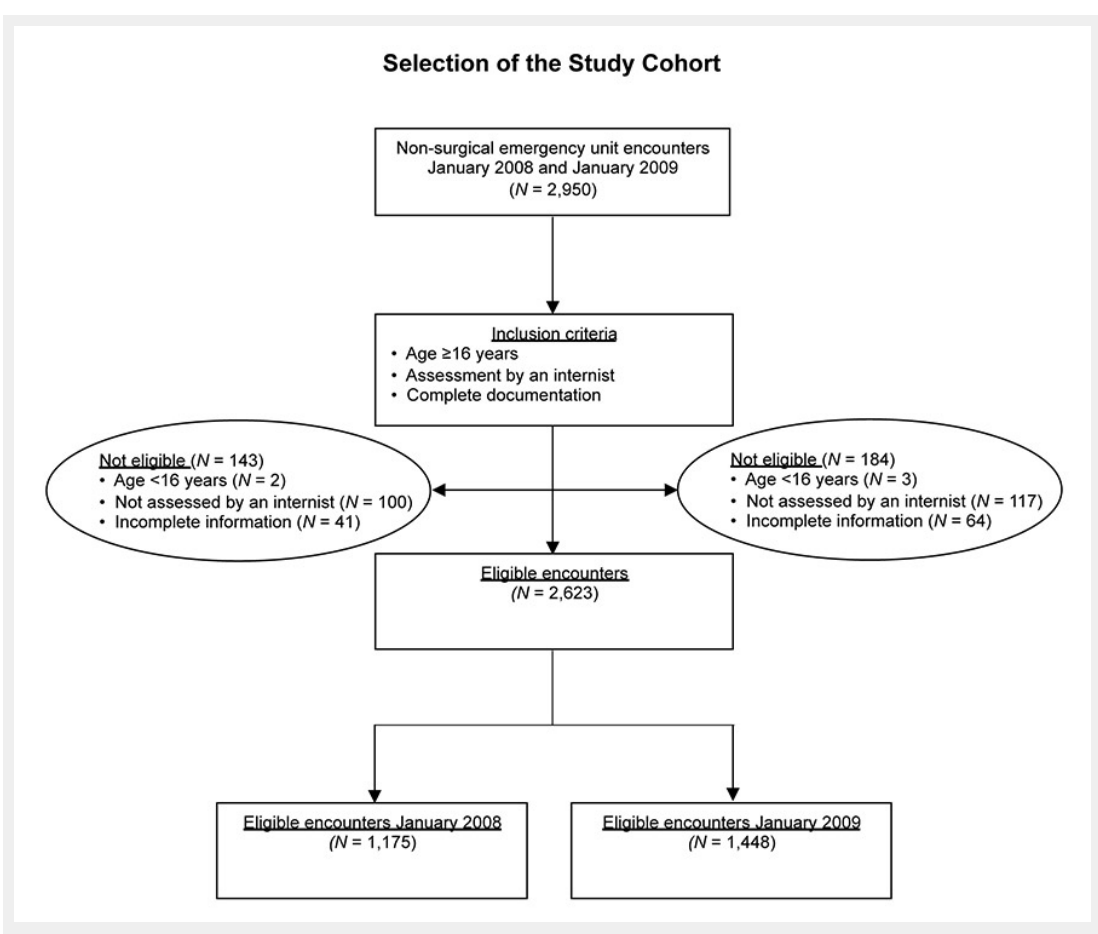
Identification and construction of the study cohort. All medical emergency unit patient-physician encounters were extracted from the clinical information system of the University Hospital Zurich between 1 January and 31 January 2008, and 1 January and 31 January 2009. Encounters were excluded if the patients age was <16 years, if the patient was managed by doctors other than internist, and if the documentation was